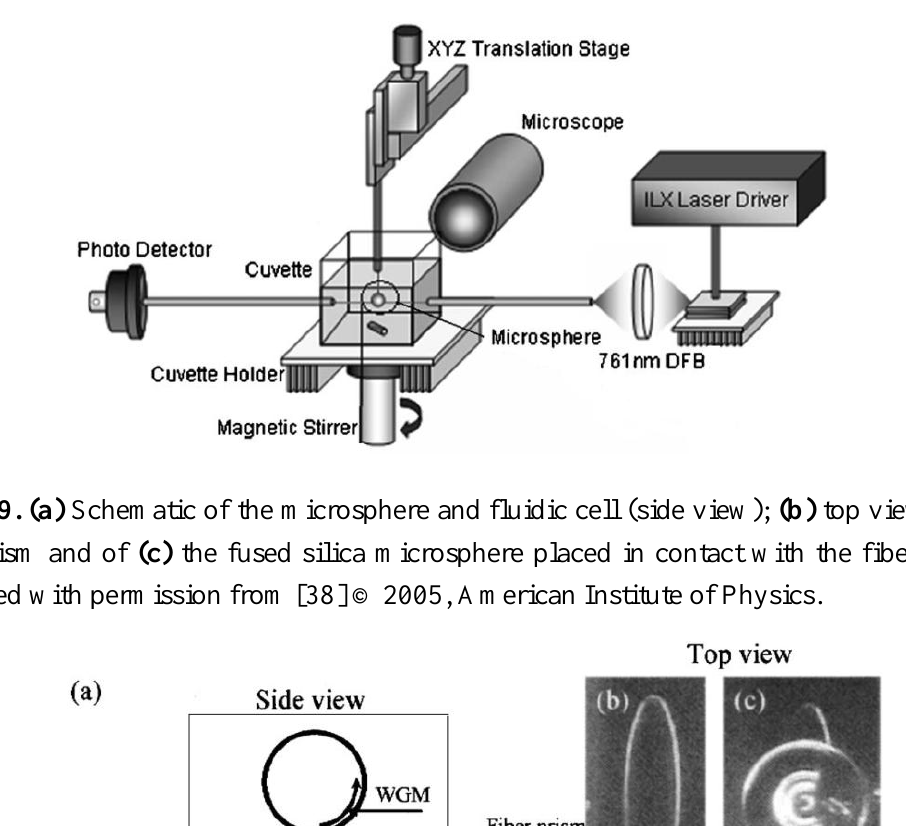
Figure 8. Experimental set-up based on a disposable cuvette of 1 cm 3 volume, temperature controlled and magnetically stirred. Reprinted with permission from [57] © 2005, American Institute of Physics.